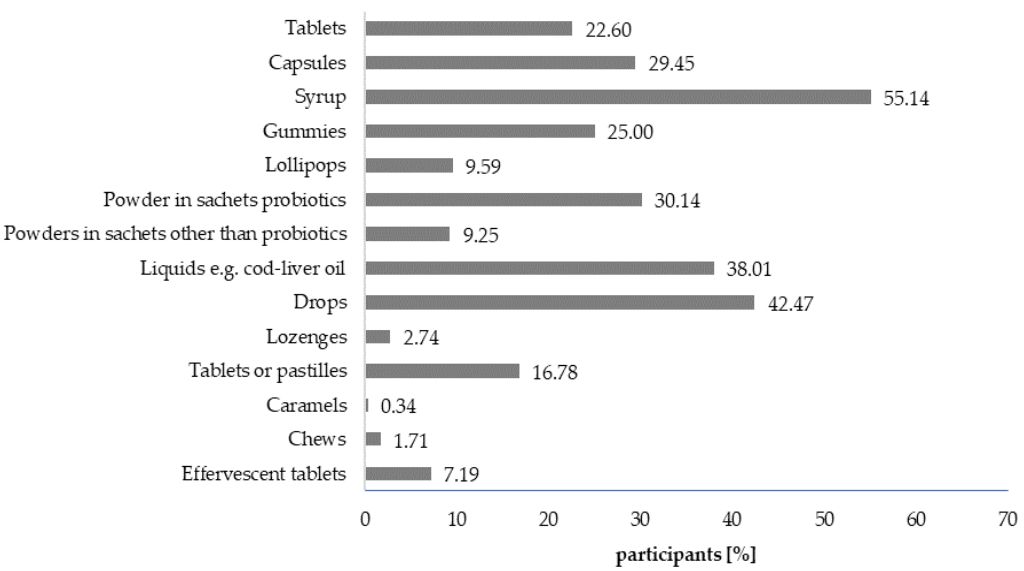
Figure 8. Formulations of dietary supplements intended for children favored by the consumers. Values do not add up to 100%, due to the fact that more than one answer was allowed.